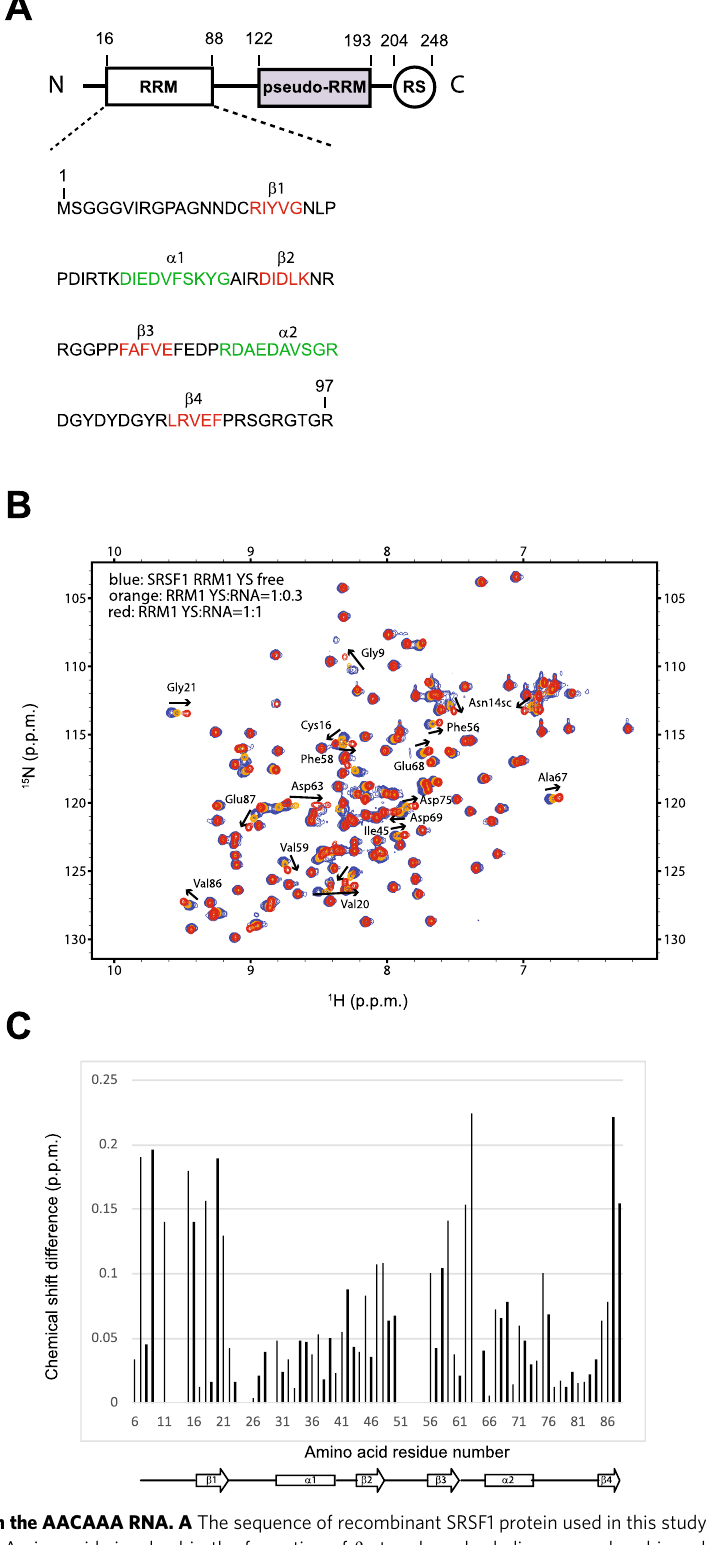
Fig. 1 SRSF1 RRM1 interaction with the AACAAA RNA. A The sequence of recombinant SRSF1 protein used in this study is shown. Amino acid numbering is according to the PDB sequence. Amino acids involved in the formation of β -strands and α -helices are colored in red and green, respectively. B Superimposition of 1 H- 15 N HSQC spectra obtained with 15 N-labeled SRSF1 RRM1 and increasing amount of unlabeled 5 ’ -AACAAA-3 ’ RNA. The titration was performed at 40 °C (313 K), in the NMR buffer. The peaks corresponding to the free and RNA-bound states (RNA:protein ratios of 0.3:1 and 1:1) are colored blue, orange, and red, respectively. The highest chemical-shift perturbations observed upon RNA binding are indicated by black arrows. C Representation of the combined chemical-shift perturbations ( Δ δ = [( δ HN) 2 + ( δ N/6.51) 2 ] 1/2 ) of SRSF1 RRM1 amides upon binding to 5 ’ -AACAAA-3 ’ RNA, as a function of RRM1 amino acid sequence. Secondary-structure elements of the protein domain are displayed at the bottom of the graph.